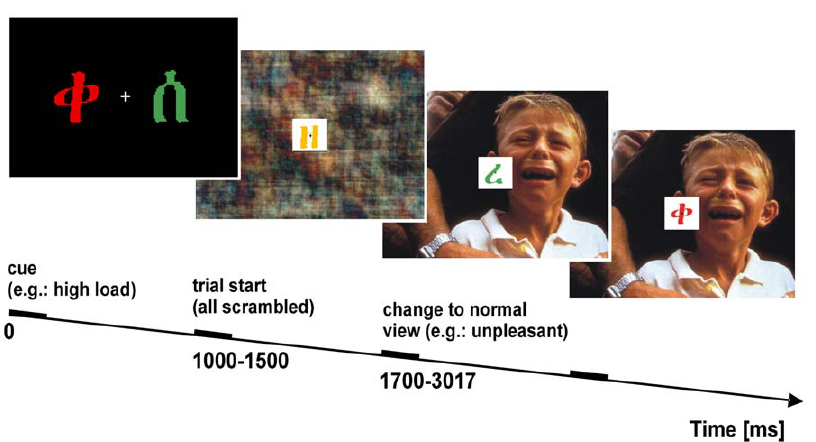
Figure 1. Schematic illustration of a trial sequence. Each trial (here: high perceptual load condition) started with a cue (1000–1500 ms) that indicated the two symbols, which had to be detected within the symbol stream. Low perceptual load required subjects to respond to the blue color of these symbols, high perceptual load involved a discrimination task (respond when one symbol is printed in red or the other symbol is printed in green). Symbols were presented at a stimulation frequency of 8.5 Hz while the underlying IAPS picture was flickering simultaneously at 12 Hz. Stimulation started with the scrambled version of the IAPS picture (see Methods for scrambling procedure) that changed between 700–1517 ms to normal view of either a neutral or an unpleasant image (here: unpleasant). Inter-trial intervals lasted 700 ms and a fixation cross was present throughout the experiment.